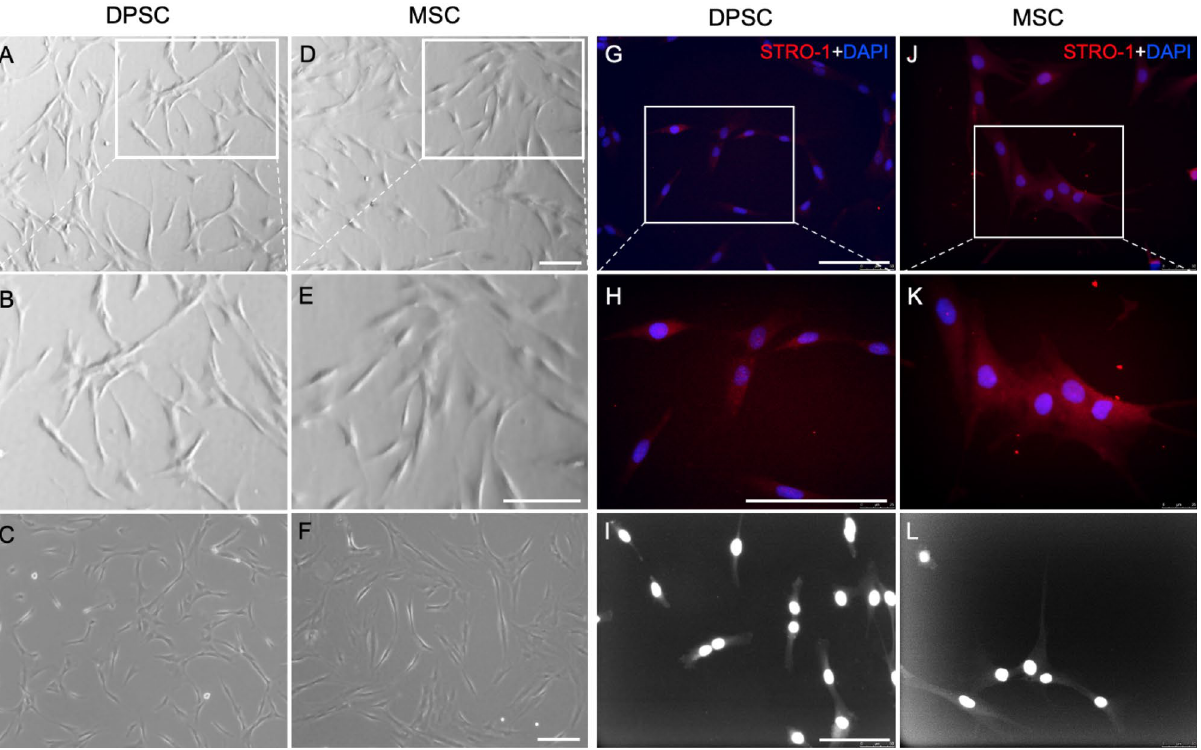
Figure 1. Characterization of human dental pulp stem cells and human bone marrow-derived mesenchymal stem cells. Commercially available DPSCs and BM-MSCs were acquired, and confluent cells (between 2nd and 4th passages) were cultured at 1 × 10 4 cells concentration in a regular growth media for 3 days. ( A – F ) Cultured DPSCs and BM-MSCs under a light microscope at day 3. ( G – L ) Cells were fixed, permeabilized, and stained with anti-STRO-1 (Red) and DAPI (Blue). Immunofluorescence staining was used to visualize DPSCs and BM-MSCs marker STRO-1 sorted cells, indicated in the representative microscopic images ( G , H and J , K ). I – L showing fluorescence phase-contrast images of DPSCs and BM-MSCs, respectively. ( B , E , H , K ) are higher magnification views of the areas indicated in ( A , D , G , J ). All scale bars: 100